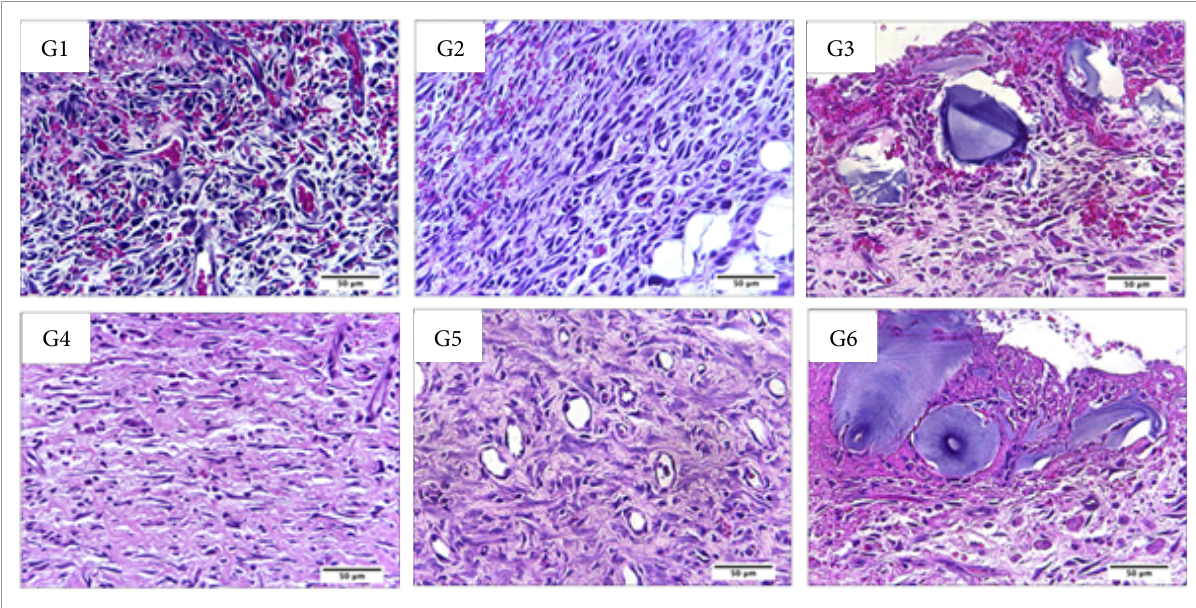
Figure 4 - Microscopic aspects of partial thickness burn wounds experimentally induced in Wistar rats seven days after the injury induction. Stain hematoxylin and eosin. Augmentation: 10x scale in μ m.